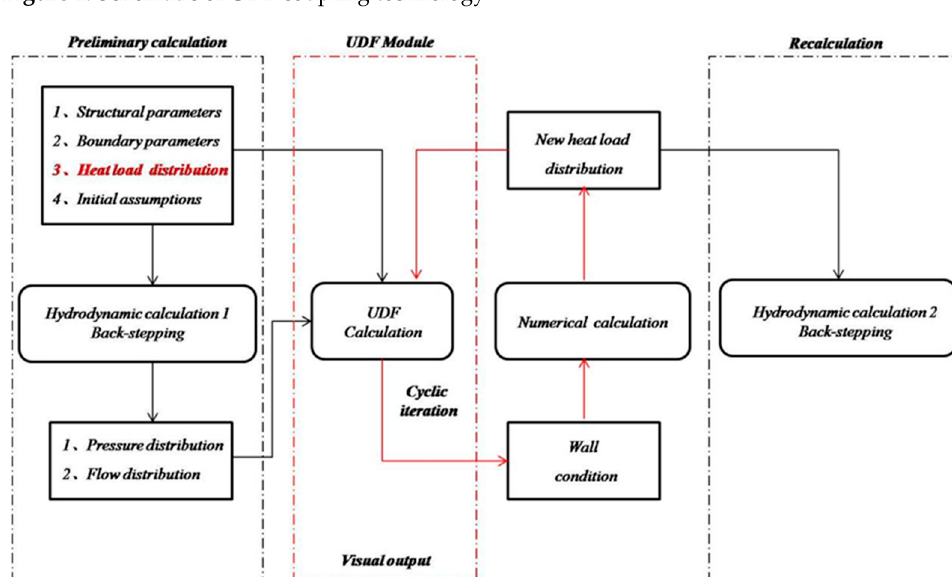
Figure 5. Schematic of simplified UDF coupling technology.